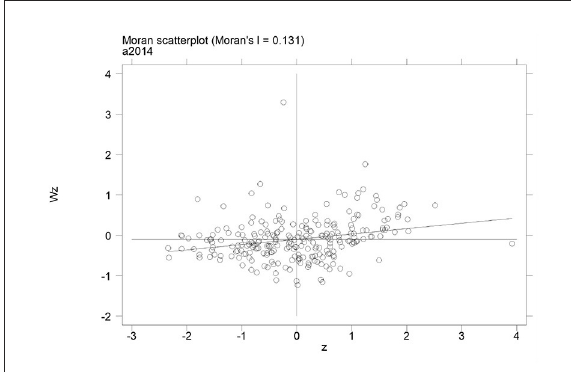
FIGURE3 Scatter plot of the Moran index for air quality improvement, If scattered points are distributed in each quadrant, it indicates that air quality improvement has significant spatial correlation.